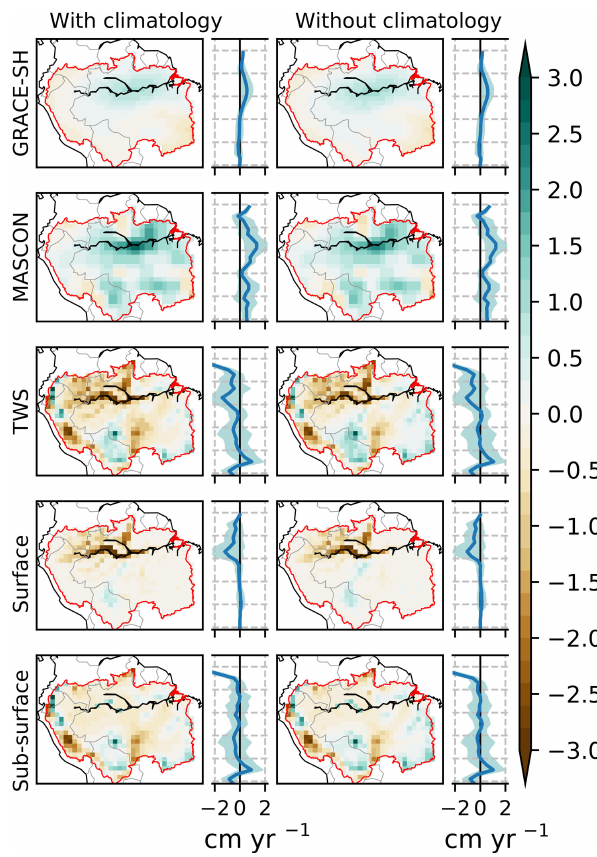
Figure 4. Same as in Fig. 3 but for the complete model–GRACE overlap period (i.e., 2002–2015). The latitudinal mean is shown on the right side of each